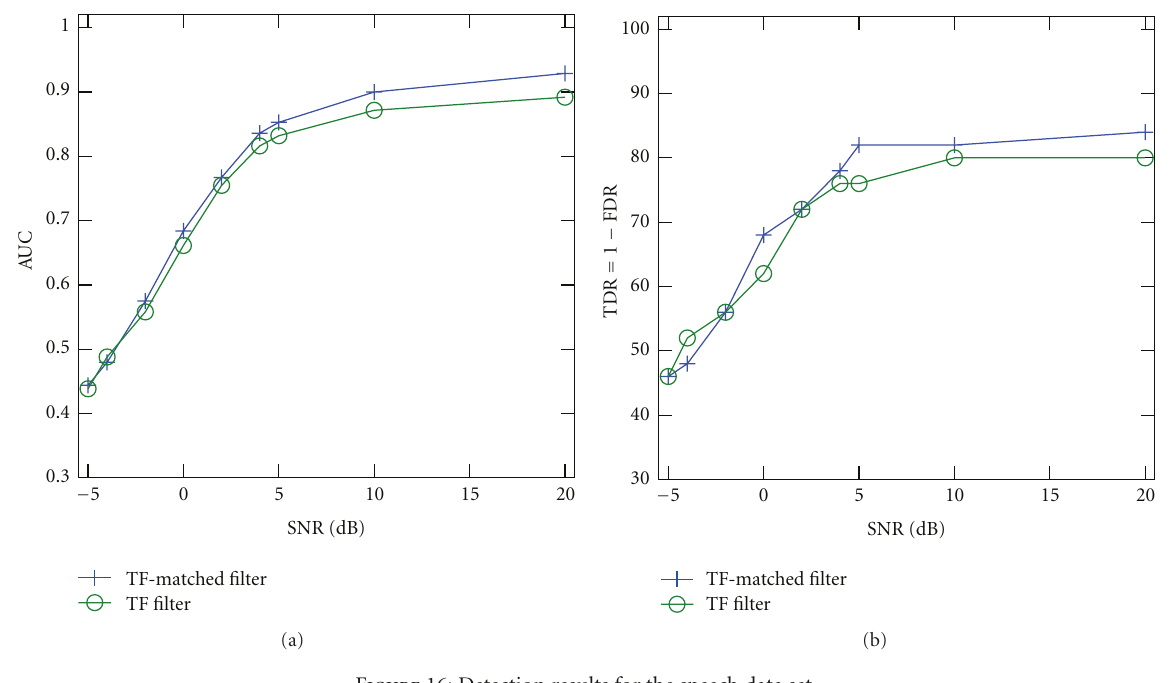
Figure 16: Detection results for the speech data